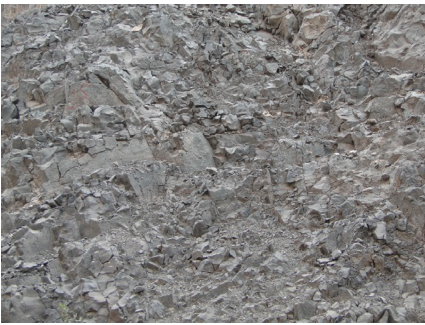
Figure 1: Jinsha Jiang crane sketch of basalt columnar joints of Baihetan Hydropower Station and